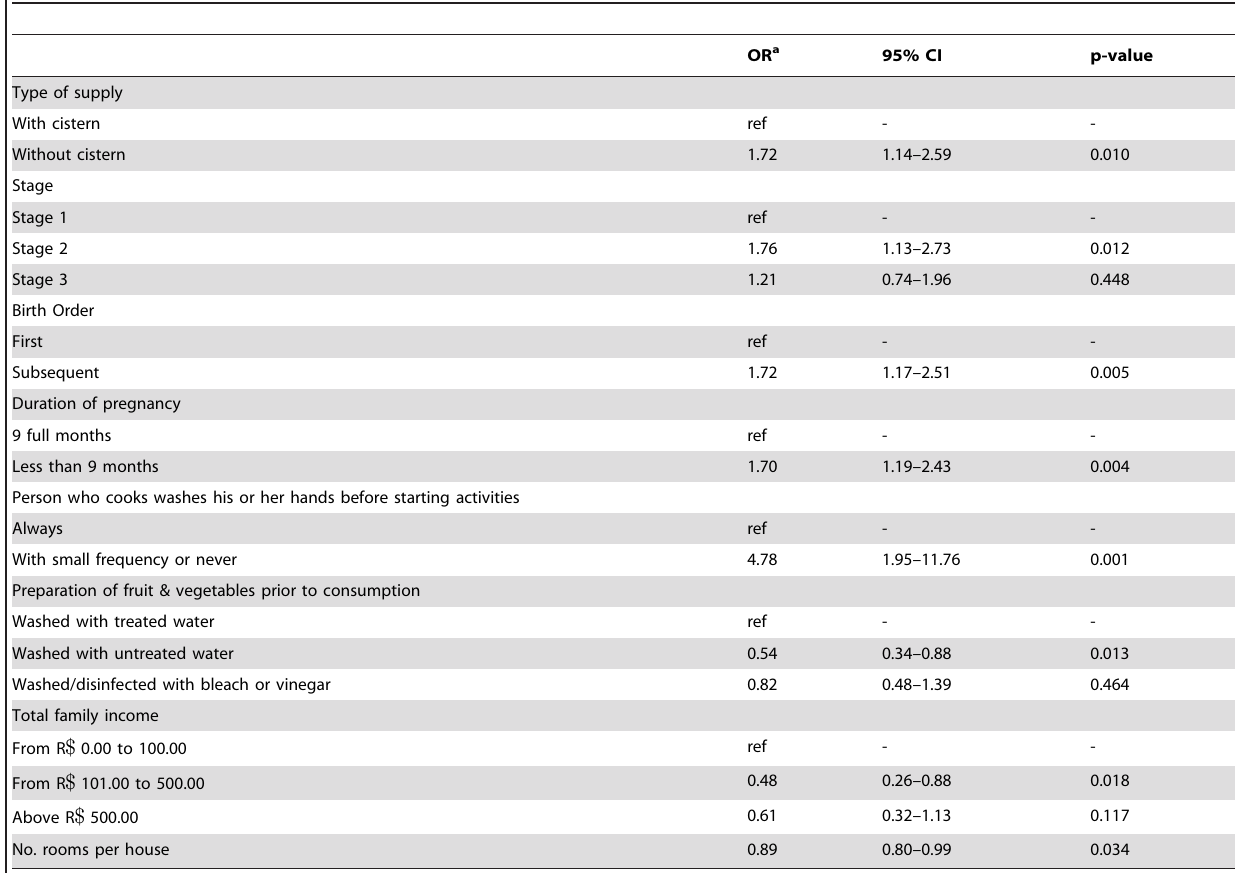
Table 6. Multivariate model for the analysis of G. duodenalis infection in children living in Northeast region of Minas Gerais State, Brazil, 2009–2010, according to socioeconomic, sanitary and pregnancy aspects.